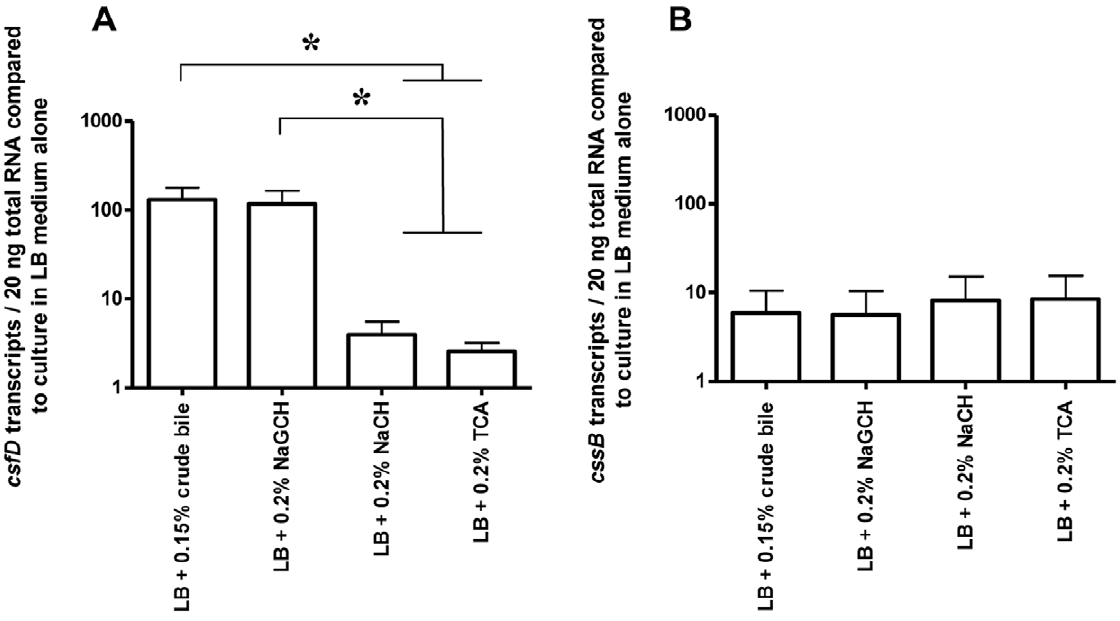
Figure 4. Levels of csfD and cssB transcription compared to in LB alone after one hour of culture. Level of csfD (A) and cssB (B) transcription in LB supplemented with crude bile or individual bile salts standardized to the level of transcription in LB medium alone, after one hour of culture. Transcription was measured by reverse transcriptase real time PCR. Bars show means and standard errors of the means of three separate experiments (strains E1785, E2265, and E3003, respectively). *, P= , 0.05